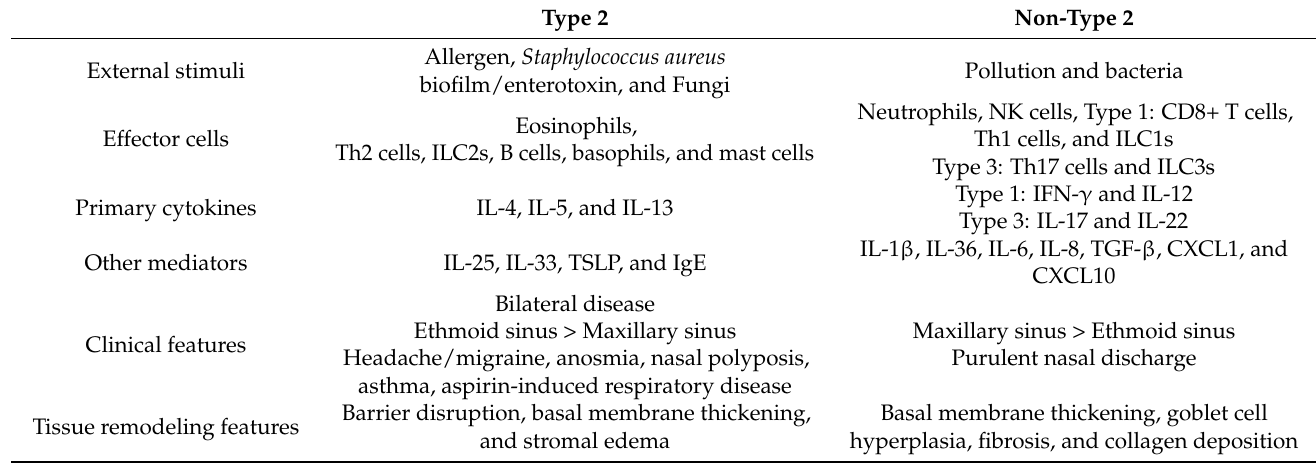
Table 1. Differences between Type 2 CRS and Non-type 2